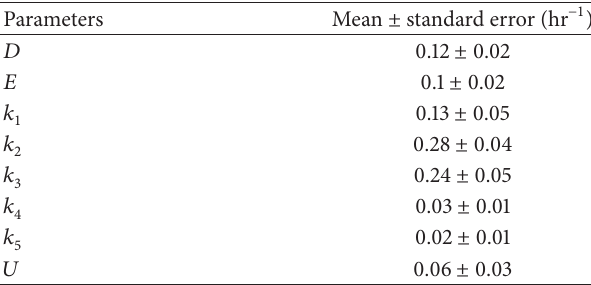
Table 1: Values of kinetic parameters for regulatory relationship in window #1 (RR #1 in Figure 4(c)) obtained by fitting mathematical model ((1), (2), and (3)) to gene expression data in Figure 4(b). Parameters Mean ± standard error (hr −1